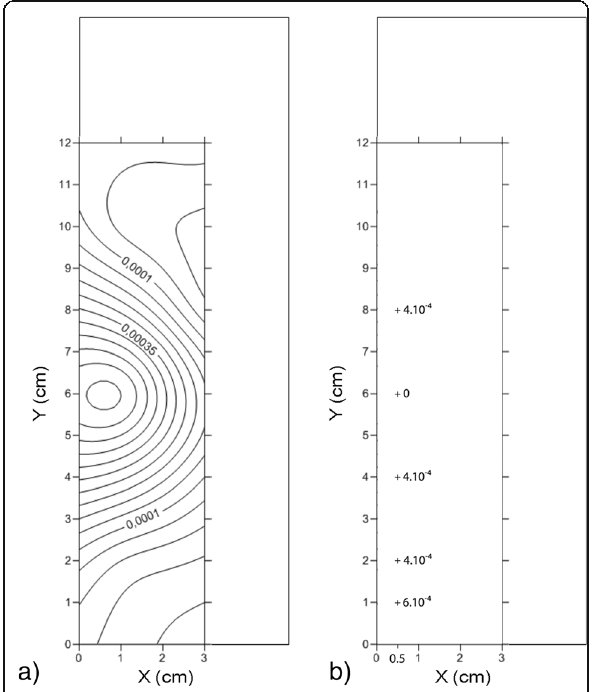
Fig. 8 Mapping of deformation inside the sample a vertically and b